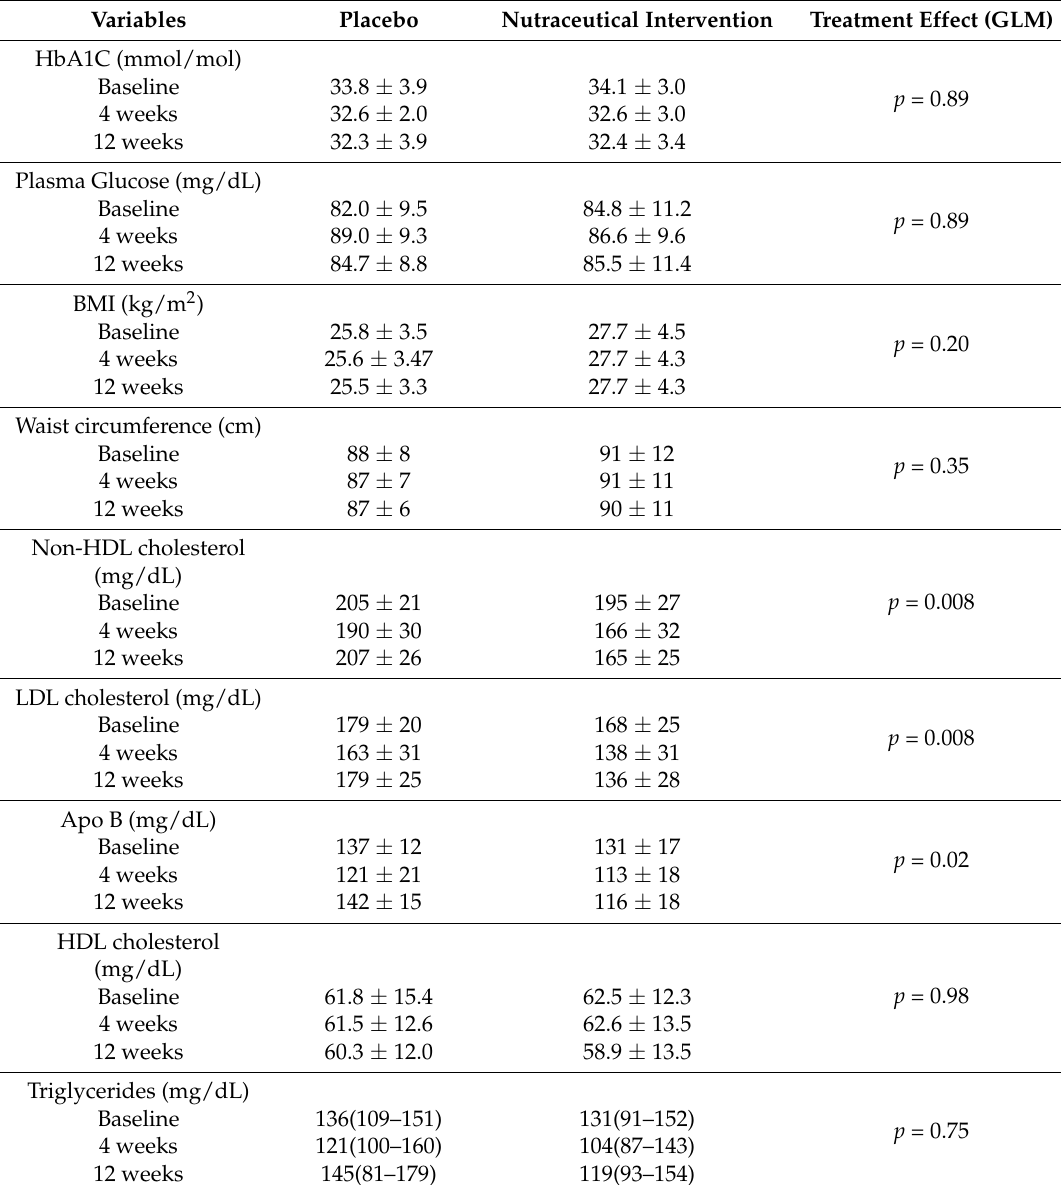
Table 2. Effect of the treatments on metabolic